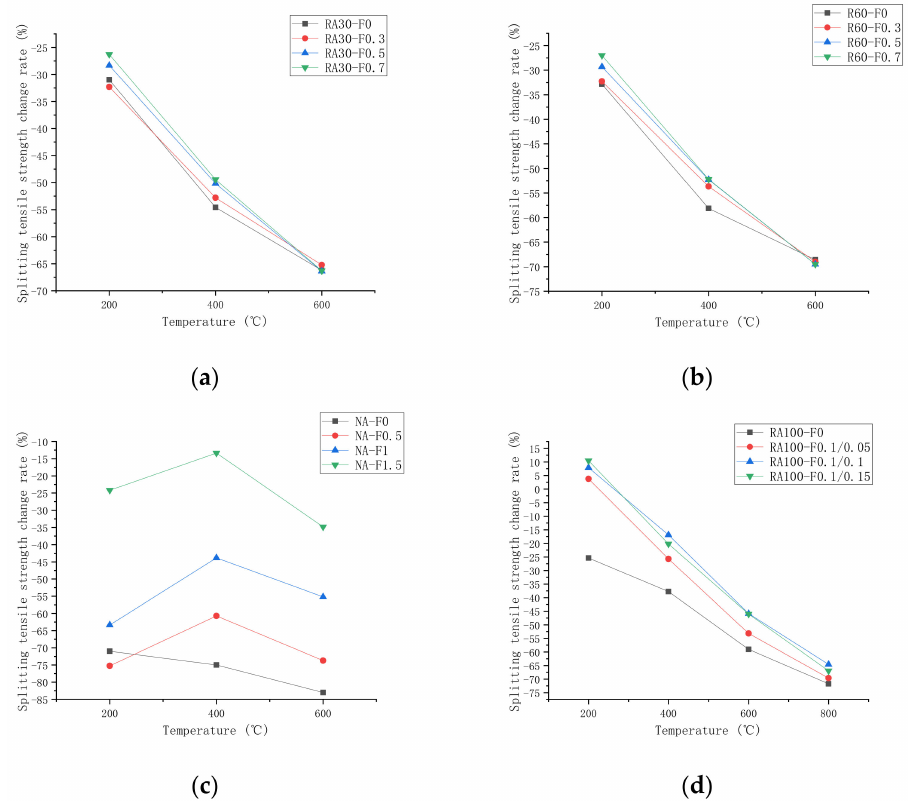
Figure 13. Effects of different fibers on tensile strength of concrete at high temperature: ( a ) Changes on tensile strength of RA(30%) with glass fiber [114]; ( b ) Changes on tensile strength of RA(60%) with glass fiber [114]; ( c ) Changes on tensile strength of RA with steel fiber [118]; ( d ) Changes on tensile strength of RA with PP–basalt hybrid fibers